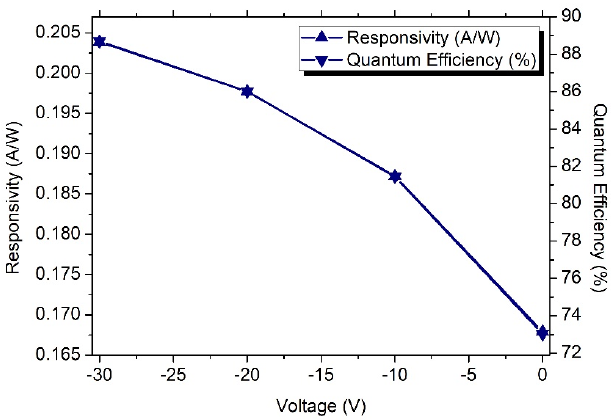
Figure 7. Responsivity peak and corresponding quantum efficiency as functions of the reverse bias voltage.